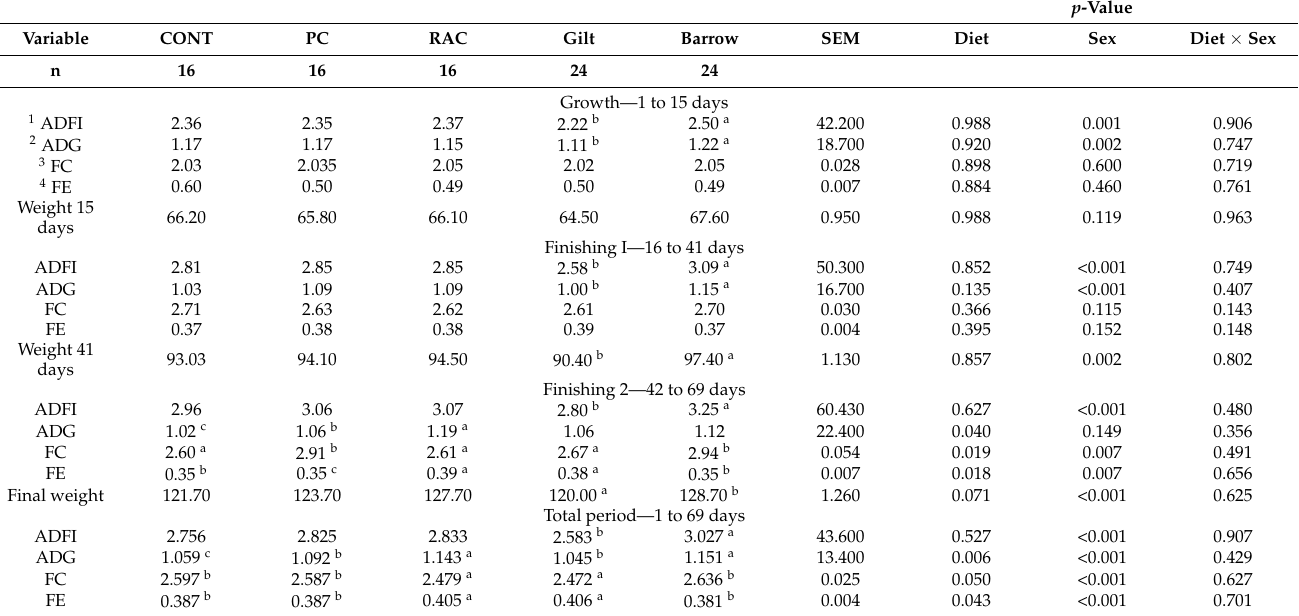
Table 2. Performance of pigs supplemented with different additives over the period (values expressed in kg).